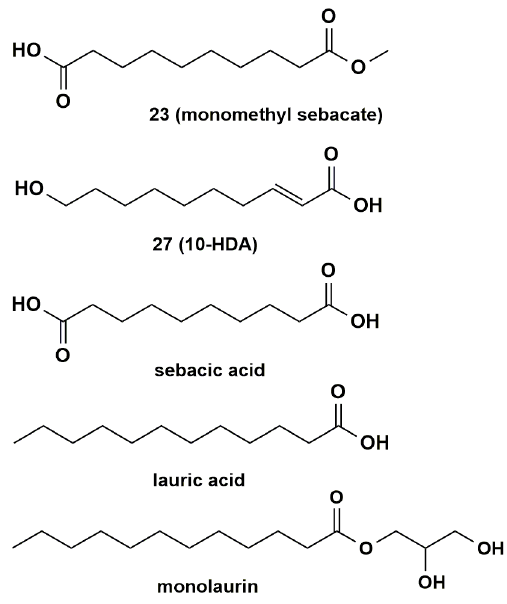
Figure 2. The reference